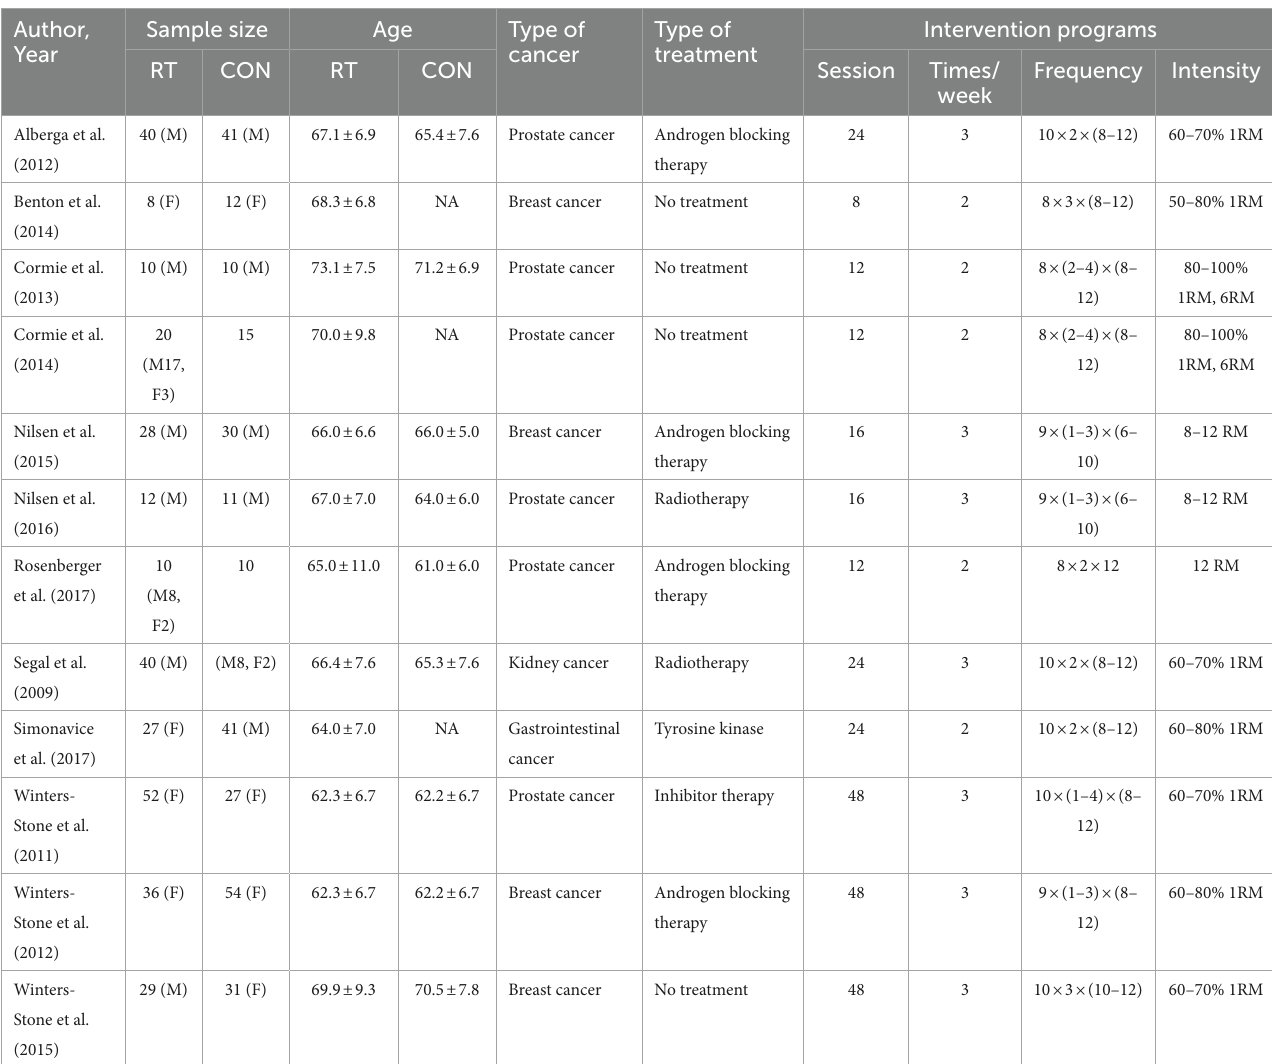
TABLE 1 Basic characteristics of included